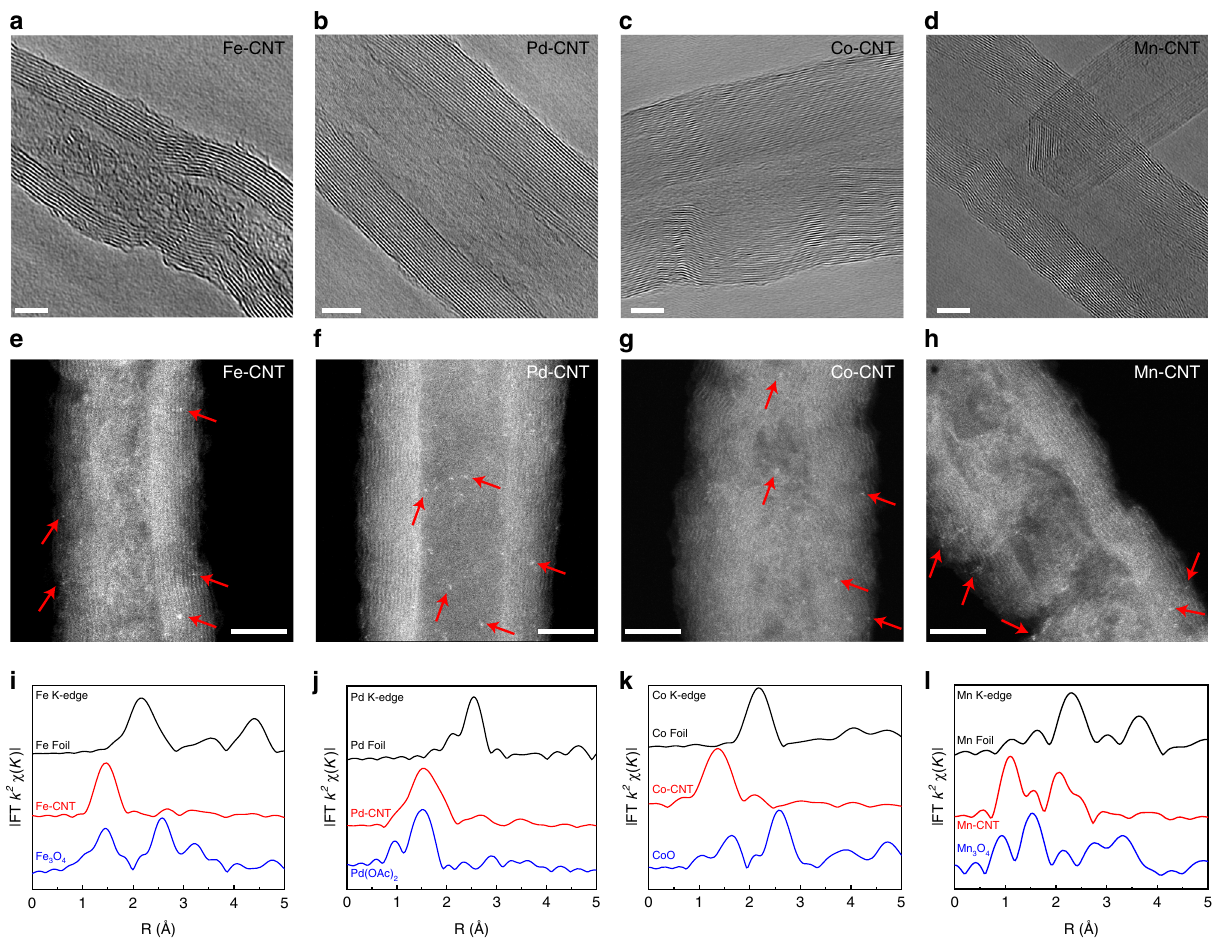
Fig. 1 TEM and XAS characterizations of M-CNT catalysts. High resolution TEM and aberration-corrected HAADF-STEM images of a , e Fe-, b , f Pd-, c , g Co-, d , h Mn-CNT are shown in upper and middle panels, respectively, in which multiple rolled graphene layers can be clearly distinguished with no metal clusters/particles observed in each sample. The bright dots in HAADF-STEM (marked by red arrows) represent some typical metal single atoms. Scale bars, 5 nm. i – l Corresponding Fourier transformed EXAFS spectra of M-CNTs are plotted in R space at the bottom panel in comparison to their